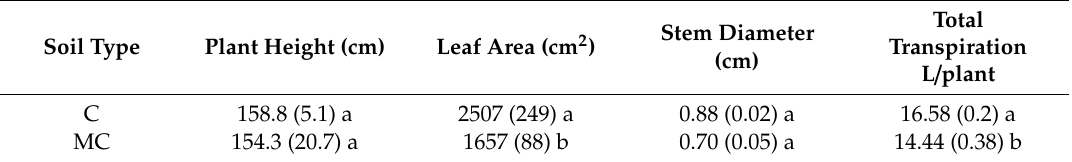
Table 2. Biometric parameters and total transpiration measured in hemp plants ( Cannabis sativa L., cv. Codimono) after 90 days of growth in a greenhouse in pots filled with soil sampled in two di ff erent sites (C and MC) in the “Valle del Sacco” area (Lazio Region, Central Italy). In each column, mean values (n = 4 ± SE) are reported. Di ff erent letters indicate significant di ff erent values (t-test, p ≤ 0.05).